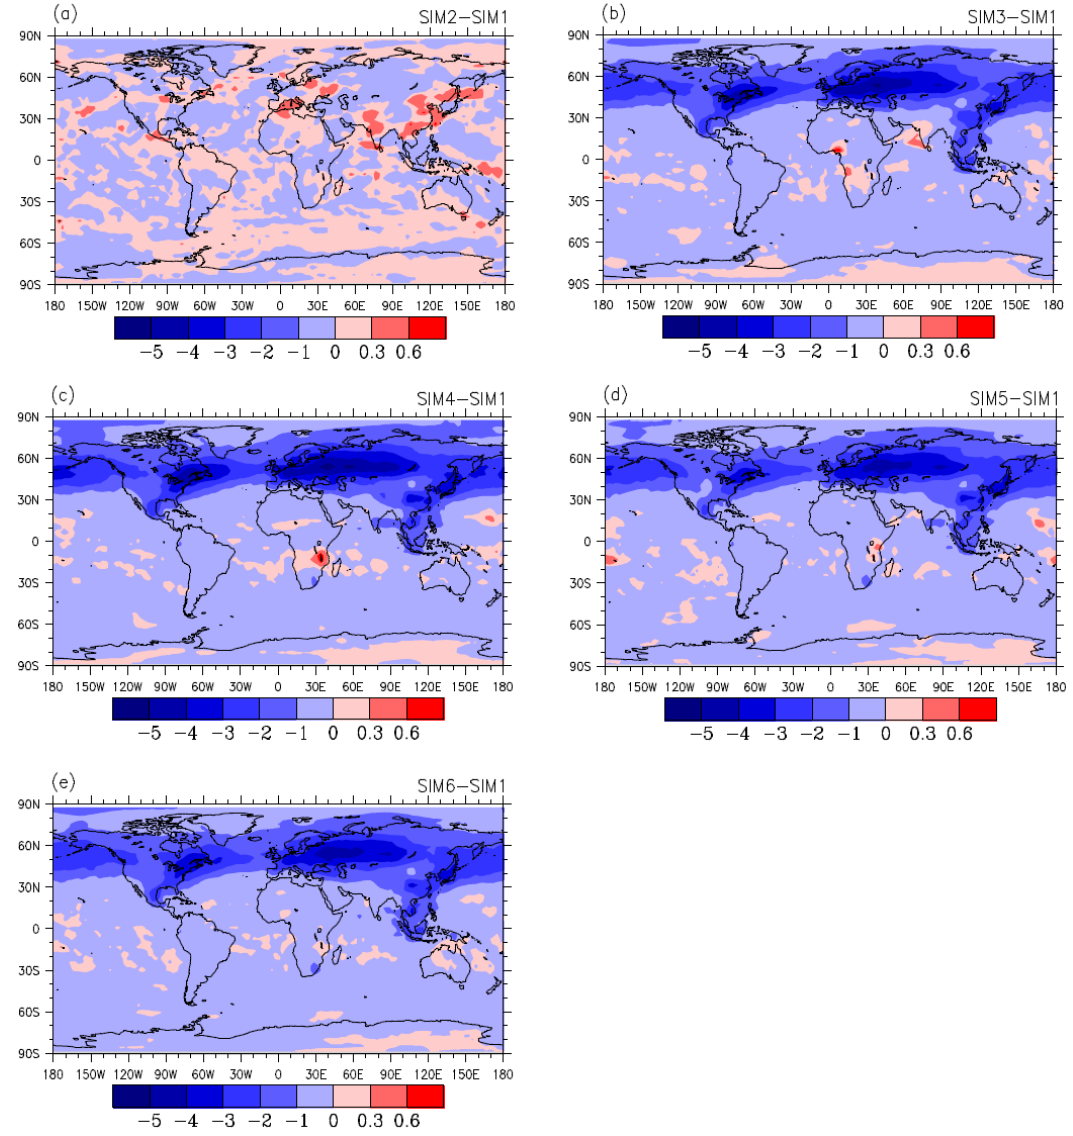
Figure 5. Global distributions of difference in simulated annual mean column CDNC (units: 10 10 m − 2 ). (a) SIM2–SIM1, (b) SIM3–SIM1, (c) SIM4–SIM1, (d) SIM5–SIM1, and (e)